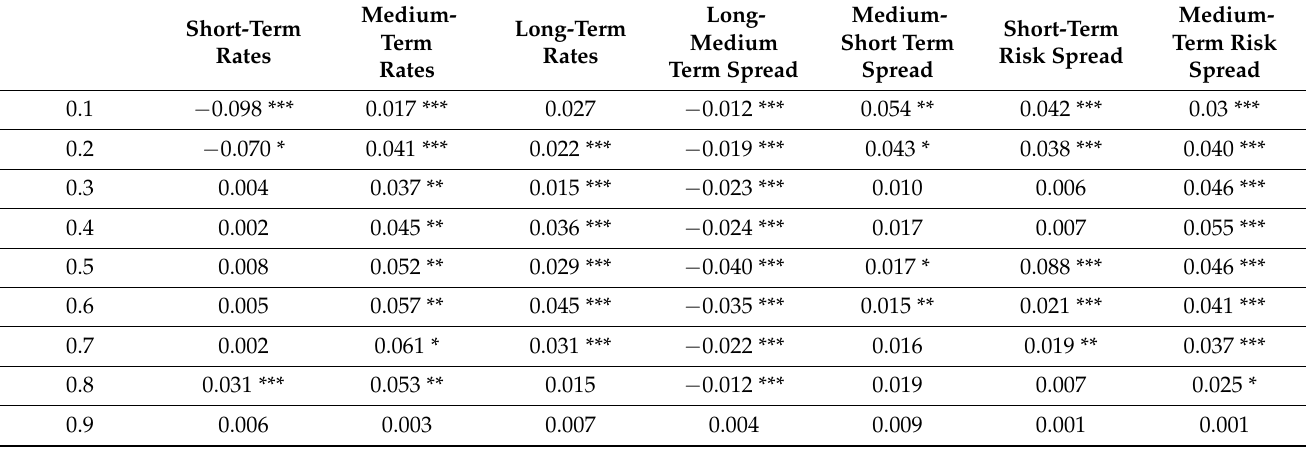
Table 4. Results at quantile level for geopolitical